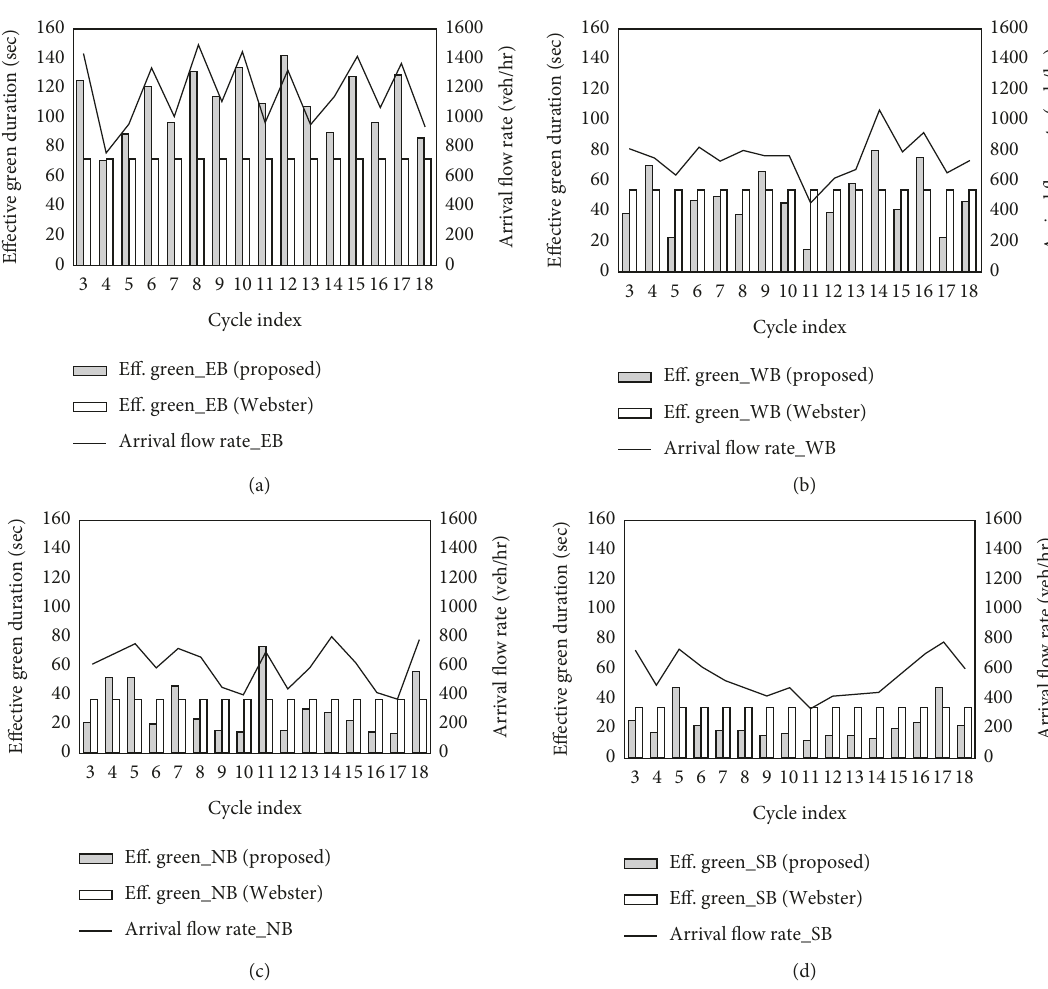
Figure 8: Variation of optimal effective green duration with respect to variation in arrival flow rate across cycles. (a) EB phase, (b) WB phase, (c) NB phase, and (d) SB